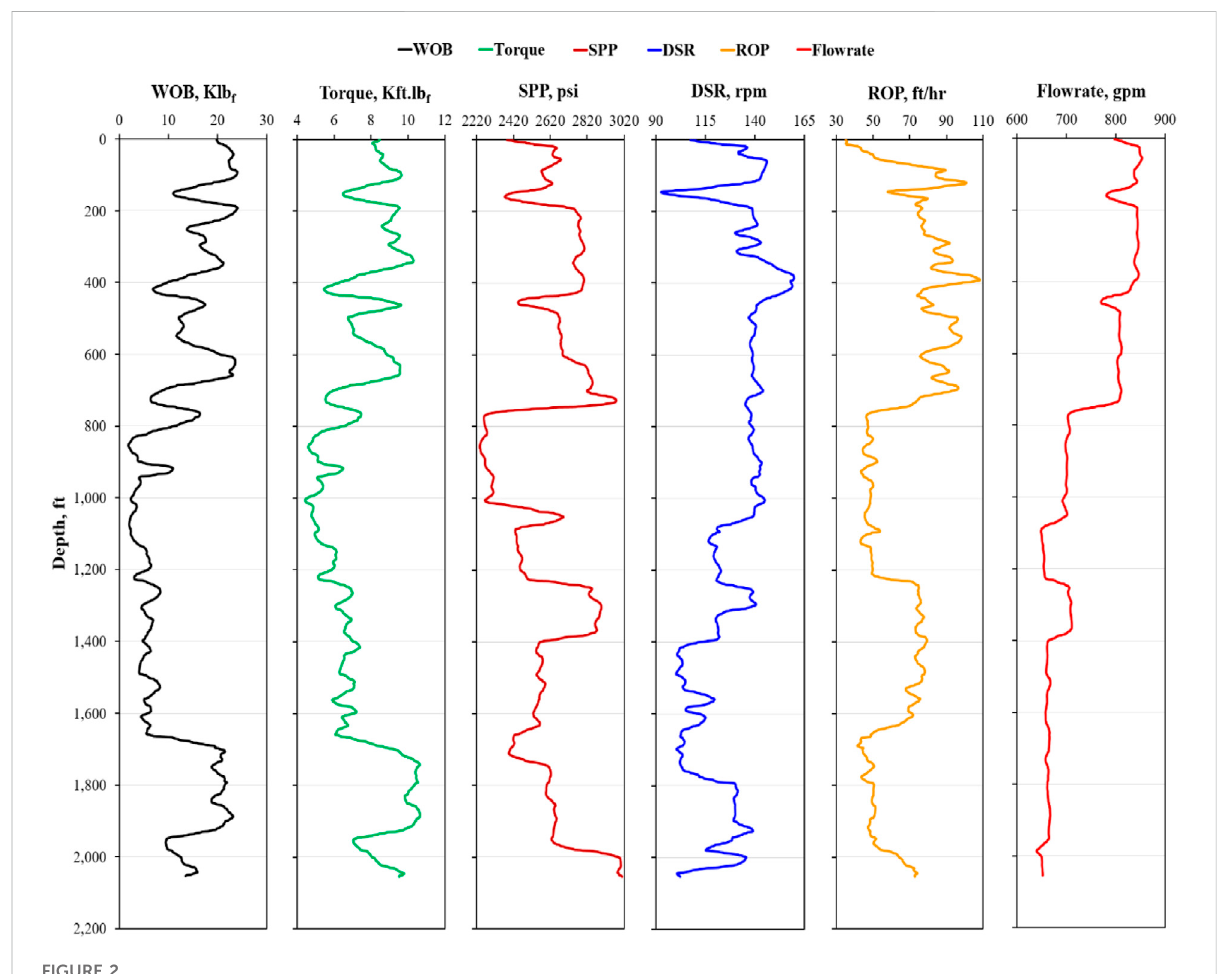
FIGURE 2 Input data used to learn the ML models were collected from